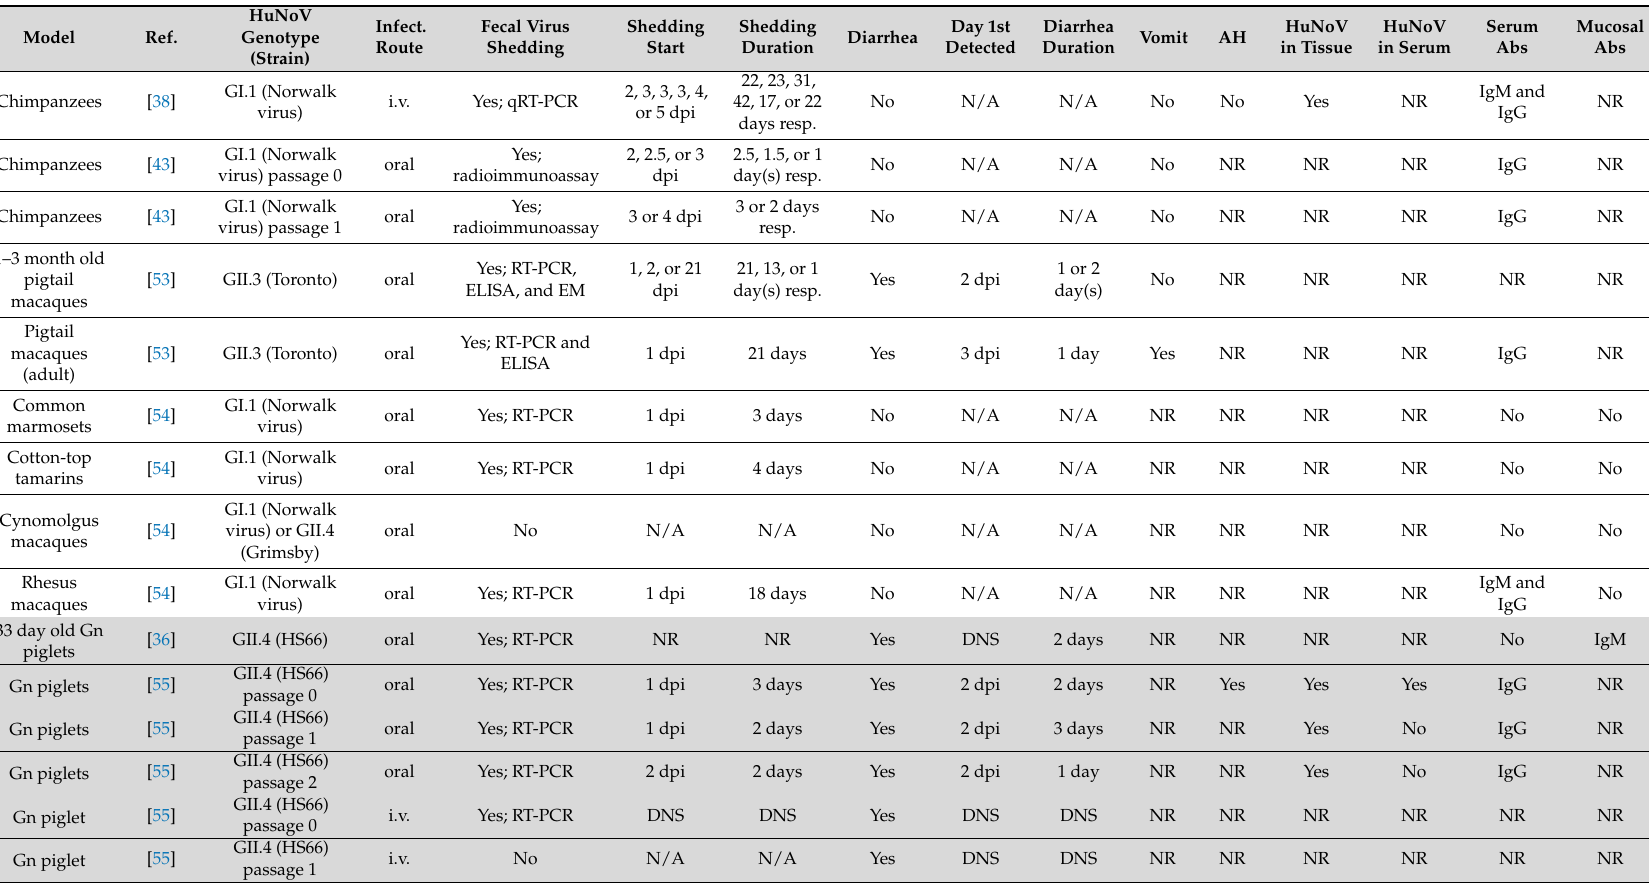
Table 1. Animal models of human norovirus (HuNoV) infection and disease. Non-human primates (NHP), gnotobiotic (Gn) piglet, natural flora piglet, Gn calf, and mouse animal models are grouped by shading. Abbreviations: humanized (Hum.), intravenous (i.v.), intraperitoneal (i.p.), days post-infection (dpi), not applicable (N/A), not reported (NR), data not shown (DNS), respectively (resp.), abnormal histopathology (AH), antibodies (Abs).